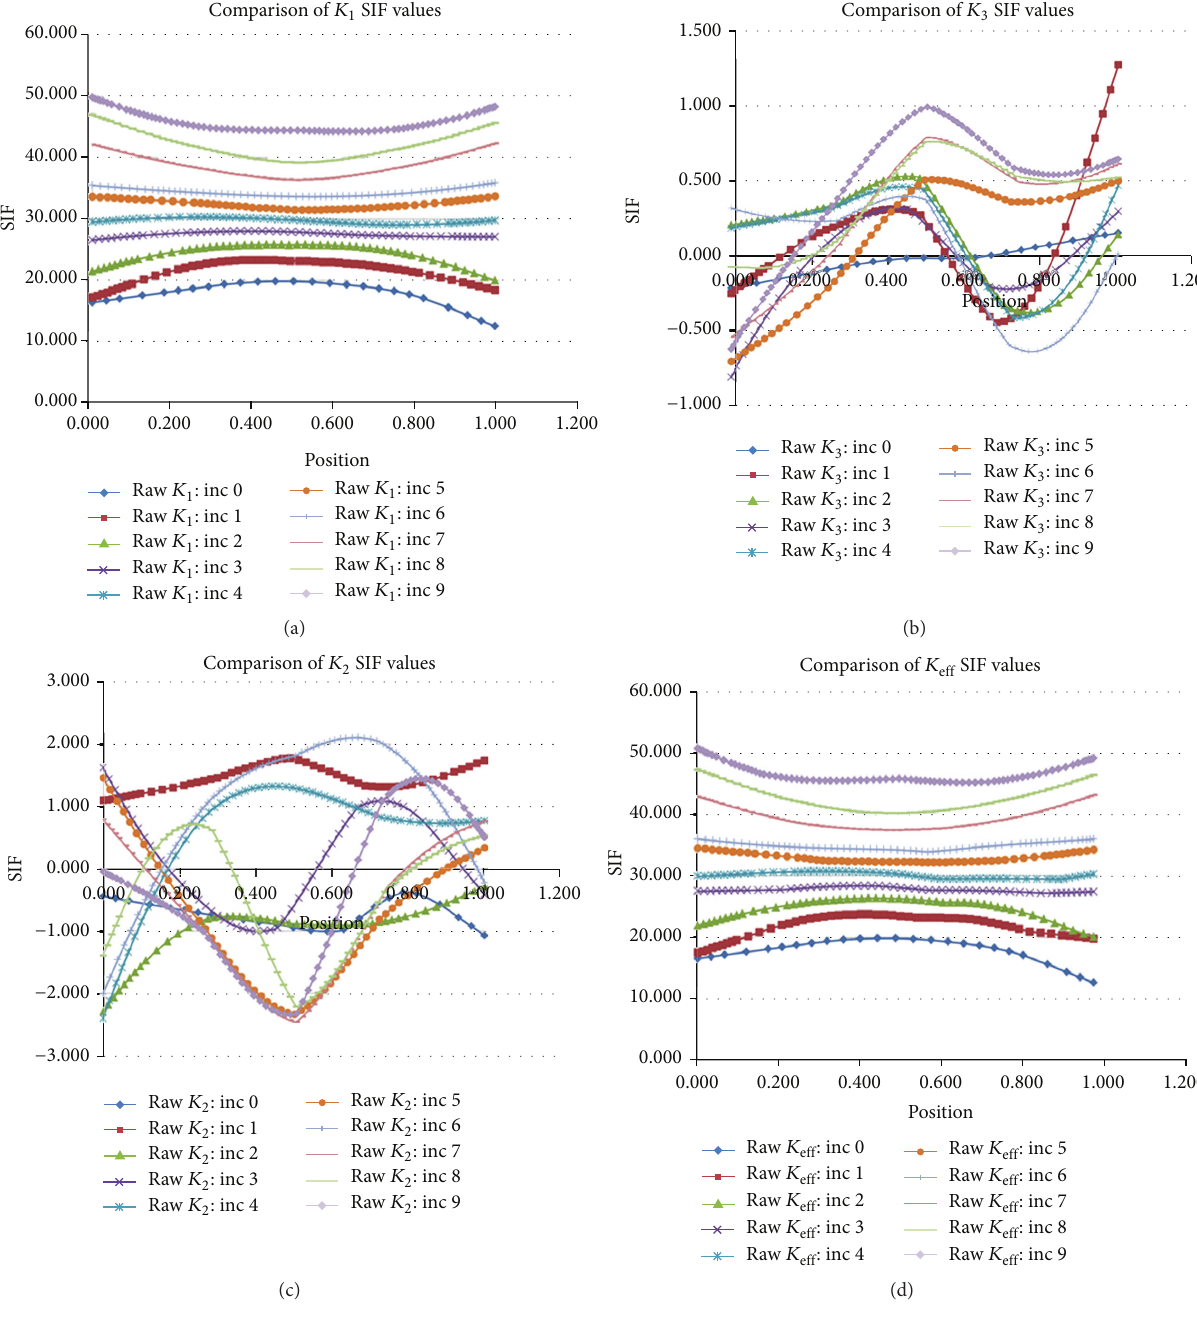
Figure 13: Stress concentration factors of cracks at different growing